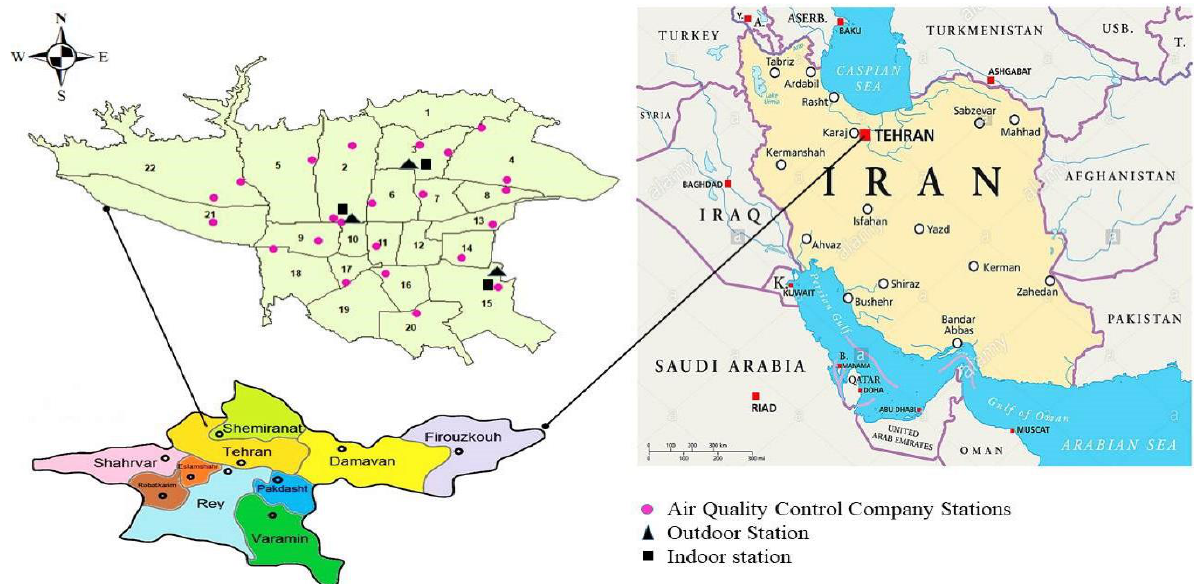
Fig. 2. Geographical location of study area and sampling stations in Tehran